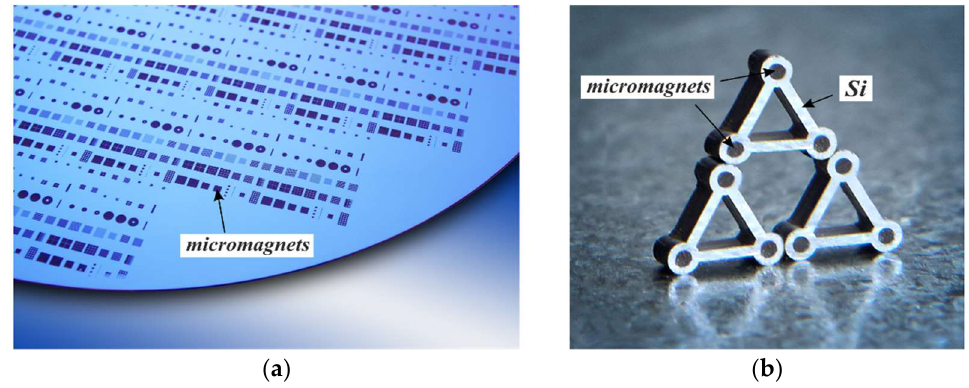
Figure 12. ( a ) PowderMEMS micromagnets fabricated from NdFeB powder inside an 8” wafer. ( b ) Triangular Si frames with magnetized NdFeB micromagnets in the corners, magnetically sticking together and to the underlying metal plate. The Si is ~700 µm thick; the micromagnets are 300 µm in diameter and extend ~600 µm into the Si. A close-up of a NdFeB-based microstructure is provided in Figure 10b.